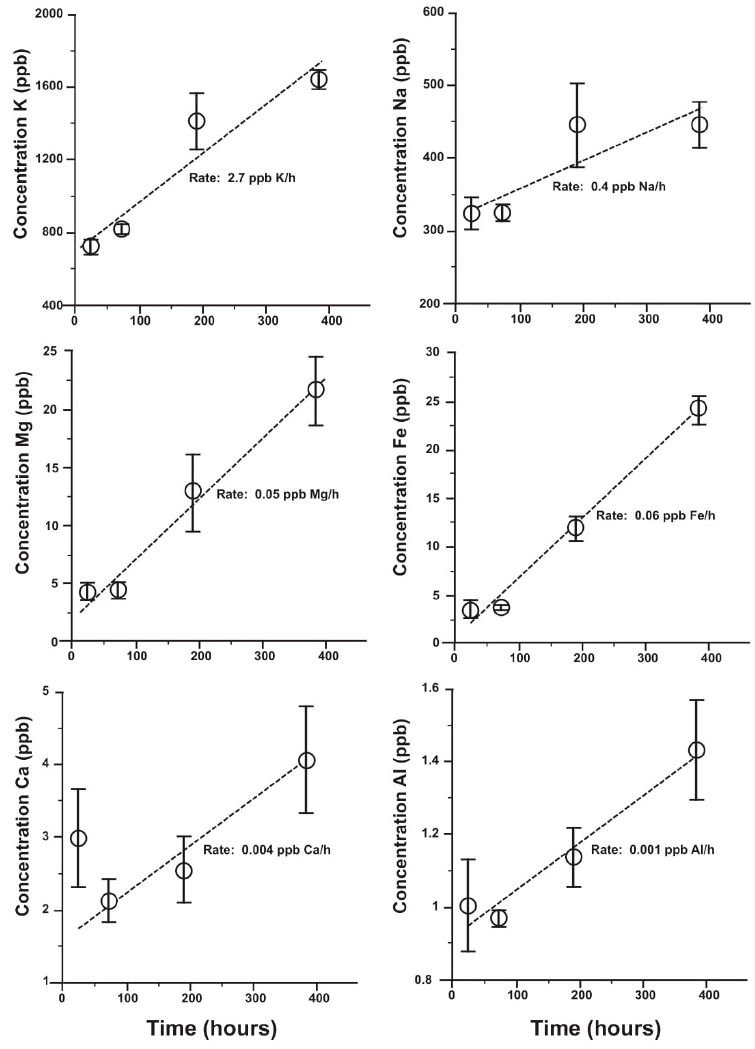
Figure 4. Concentration of K, Na, Mg, Fe, Ca, and Al dissolved from WP glaucony in acidified H 2 O (pH 3.7) over ~400 h. Black lines are the line of best fit and rates of elemental release are provided.